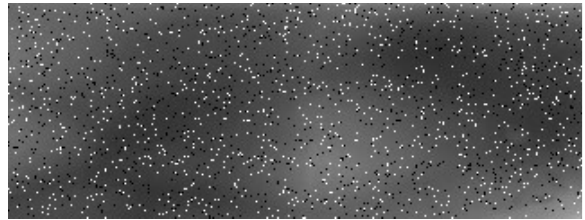
Figure 6. Example of ROI image after setting (0.1) the “Salt and pepper” noise density.